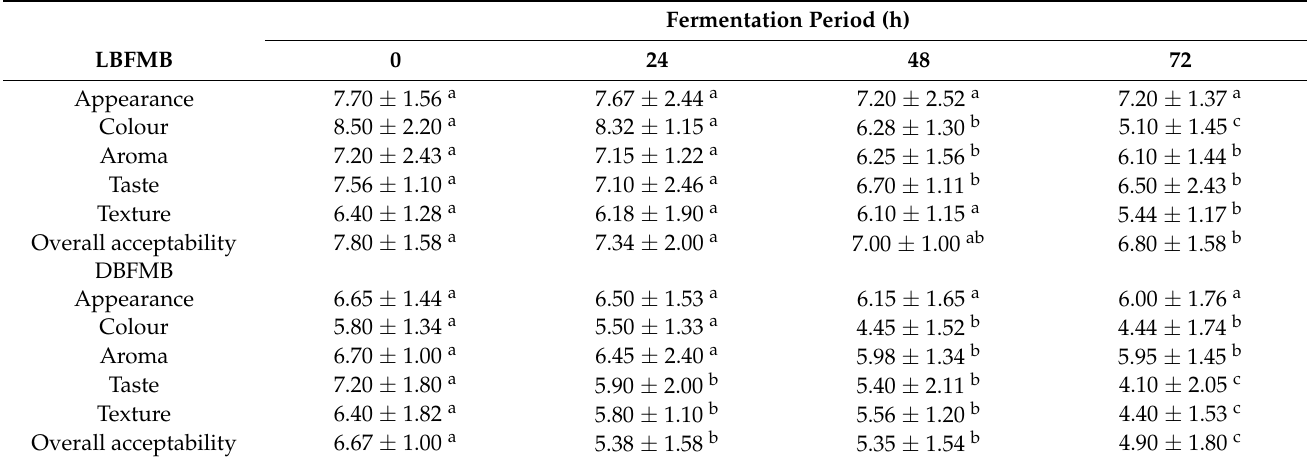
Table 6. Sensory evaluation of spontaneously fermented finger millet